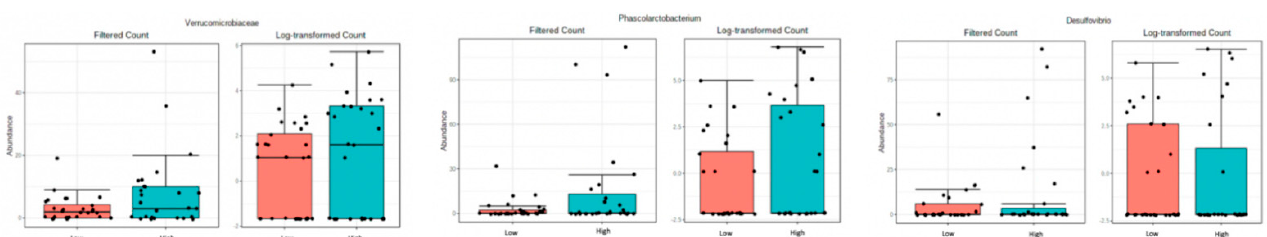
Figure 3. Bacterial taxa differing significantly when comparing individuals with higher and lower consumption of yogurt and fermented dairy ( A ), fruit and whole grains ( B ), and olive oil ( C ) (FDR < 0.05). Red boxes represent participants with lower consumption, and blue boxes represent participants with higher consumption of the specified food group.